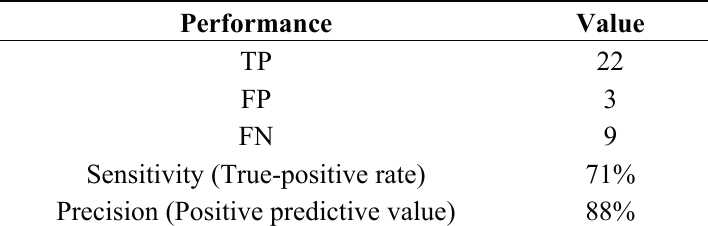
Table 2. Performance